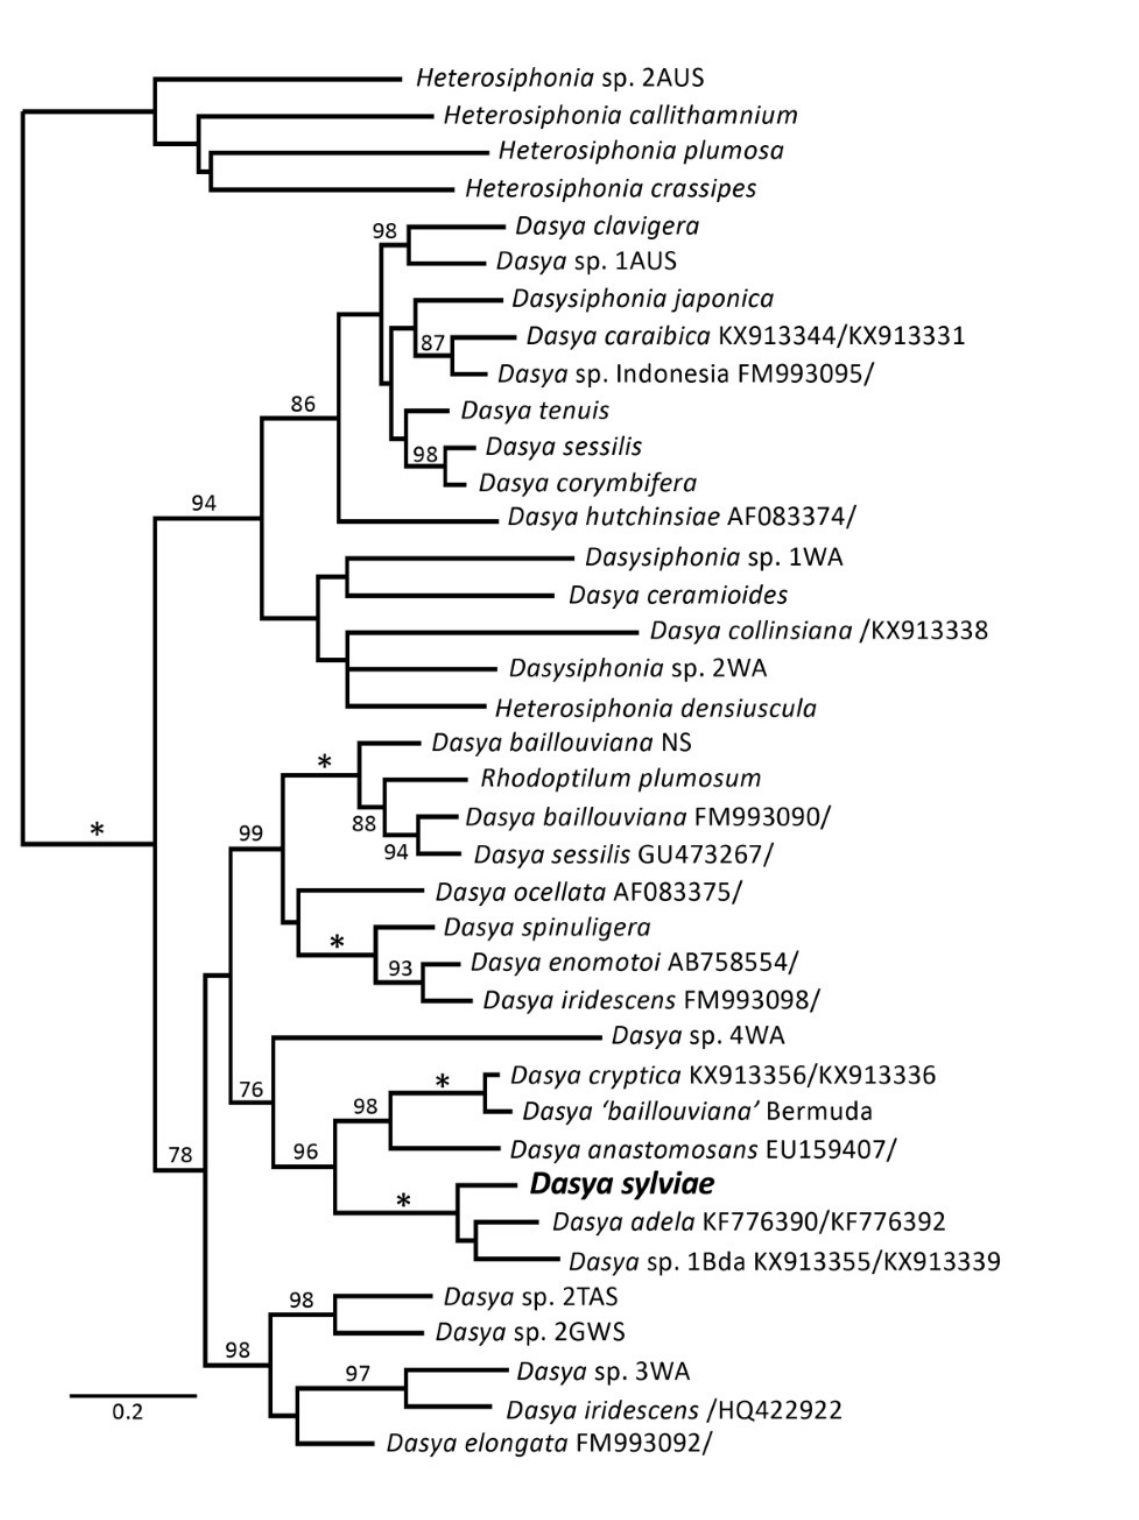
Fig. 1. Concatenated COI-5P and rbc L RAxML tree, partitioned by gene and codon, GTR+I+G with 1000 bootstrap replications (only bootstrap values > 75% shown). Asterisks (*) denote 100% bootstrap support. Sequences taken from GenBank are indicated by including their accession numbers in parentheses ( rbc L / COI-5P). The novel genetic group, Dasya sylviae sp. nov., is presented in bold